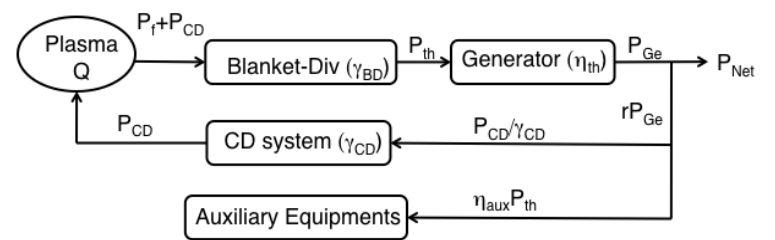
Figure 10. Power flow diagram of SSTR